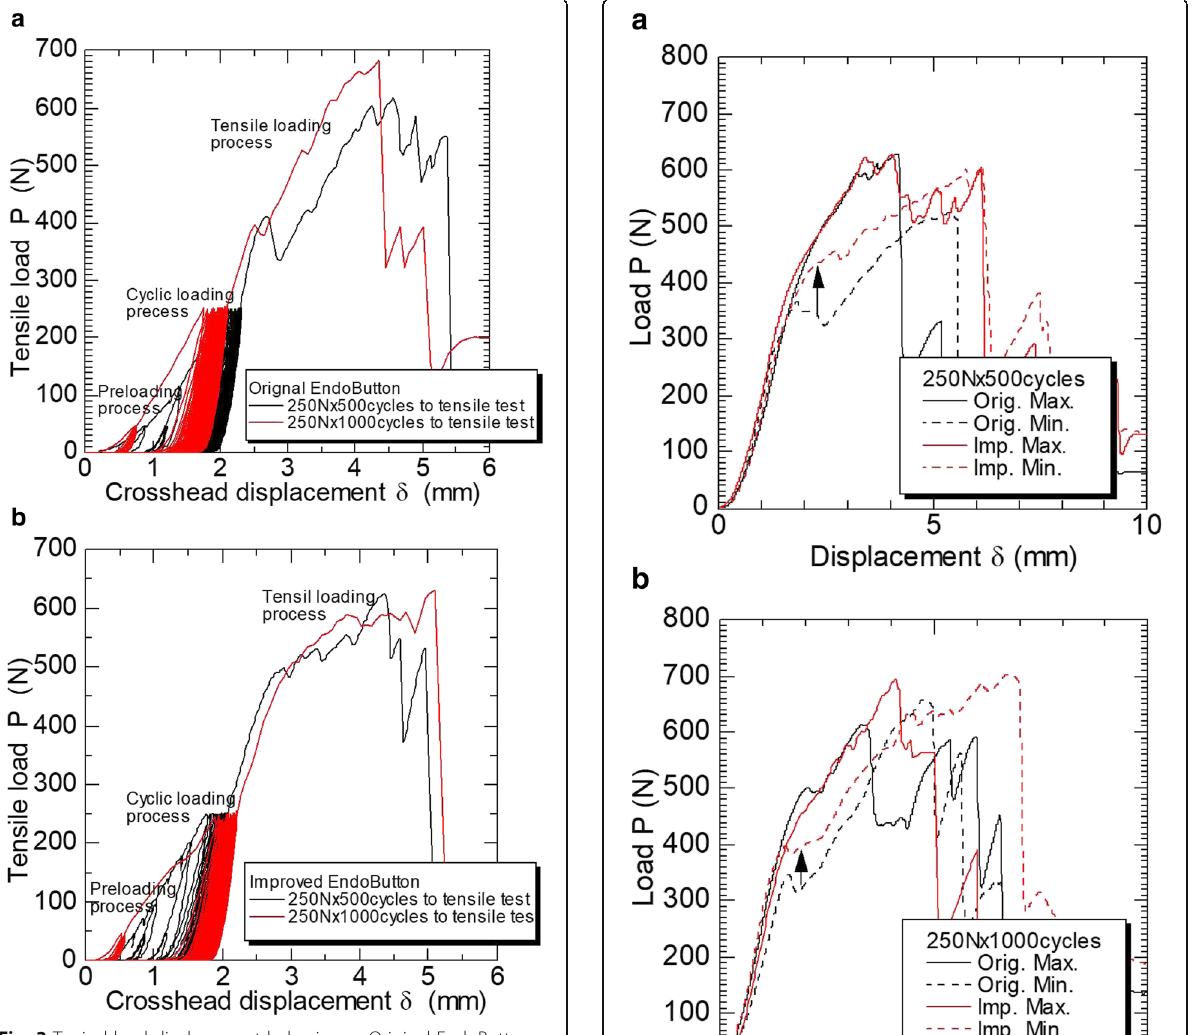
Fig. 3 Typical load-displacement behaviors. a Original EndoButton ( b ) Improved EndoButton. The breaking strengths with both EndoButtons were higher than 600 N